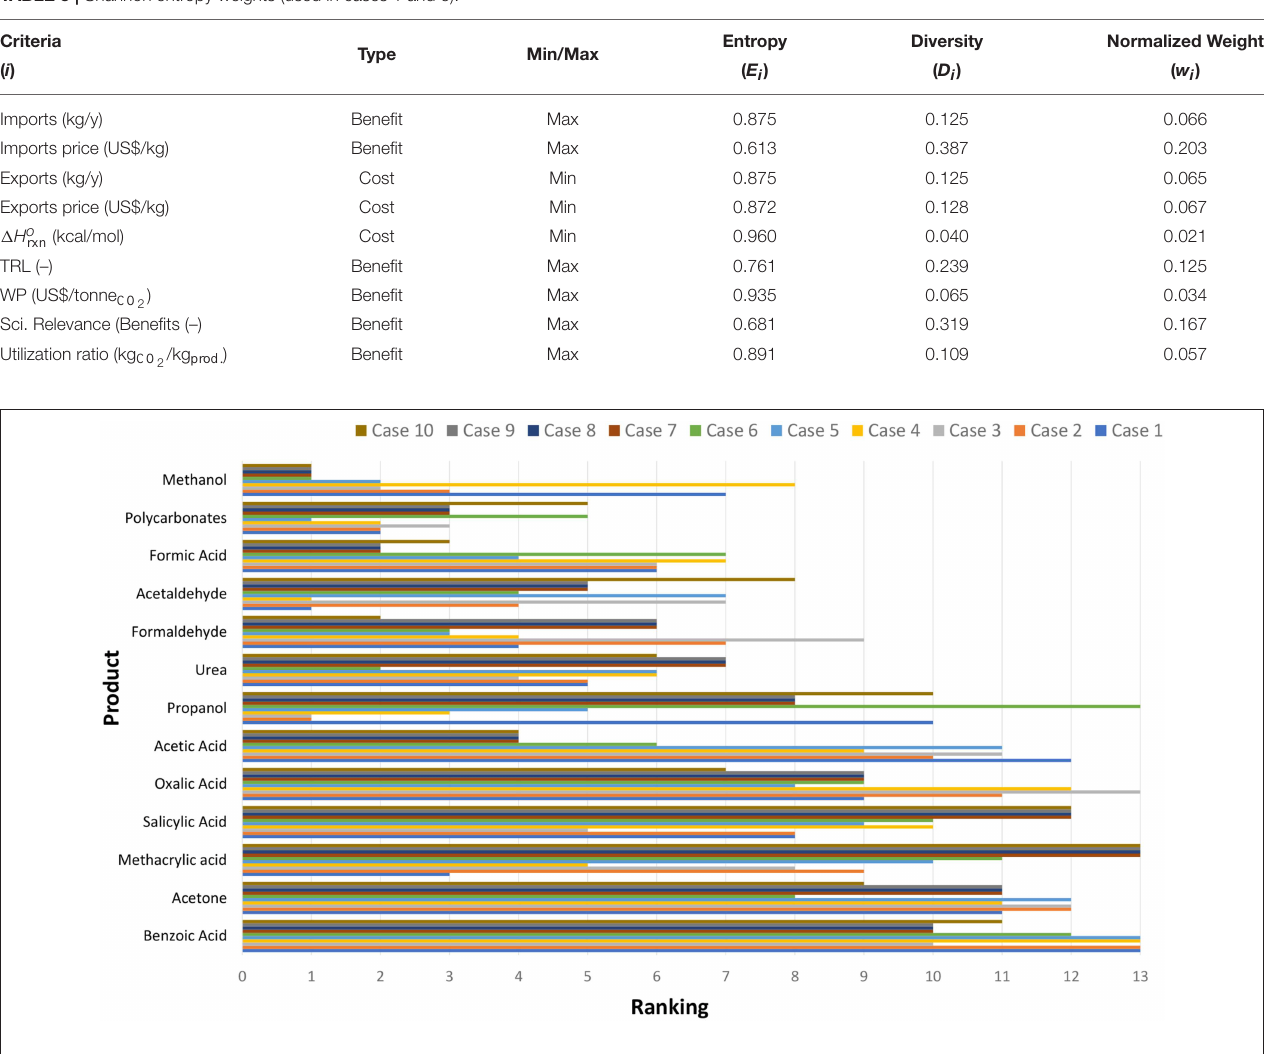
FIGURE 5 | Sensitivity study results.